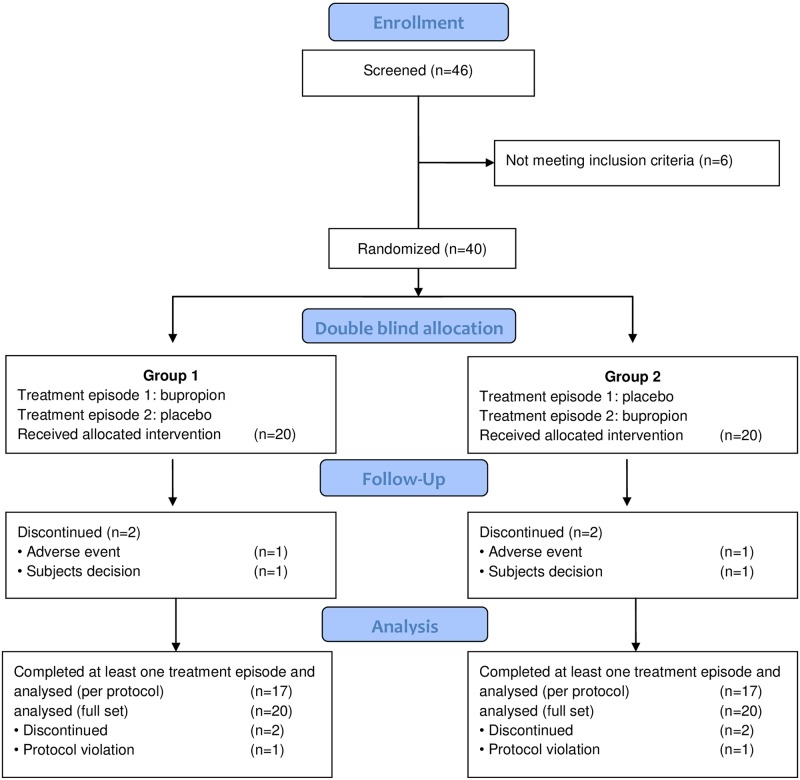
CONSORT flow diagram.